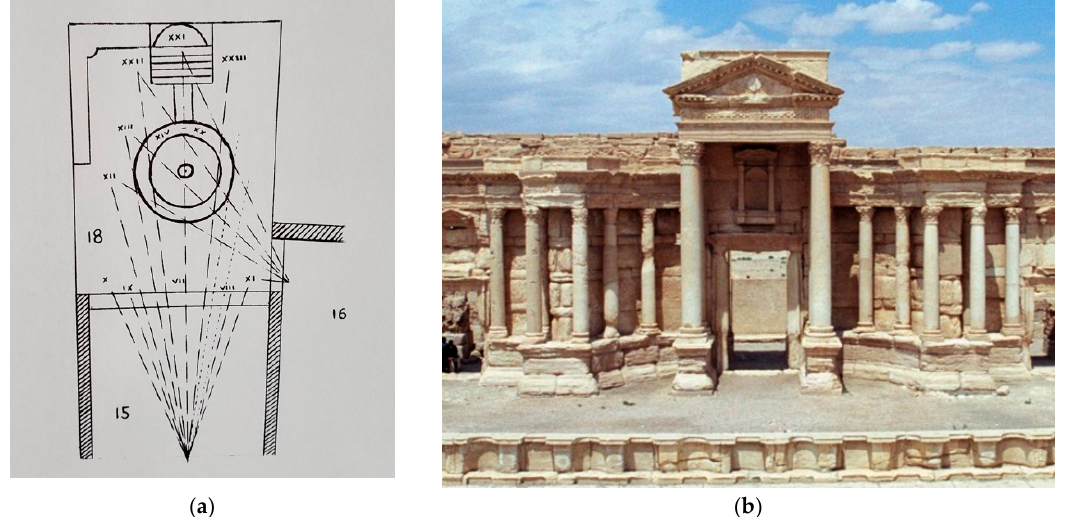
Figure 5. ( a ) Floorplan of the garden, with sightlines. The sculpture locations are indicated by Roman numerals. Illustration Courtesy: (Dwyer 1974, p. 68; used by permission); ( b ) Roman theatre at Palmyra, before the recent destruction by ISIL. Image Courtesy: J. Strzelecki, Wikipedia Commons.